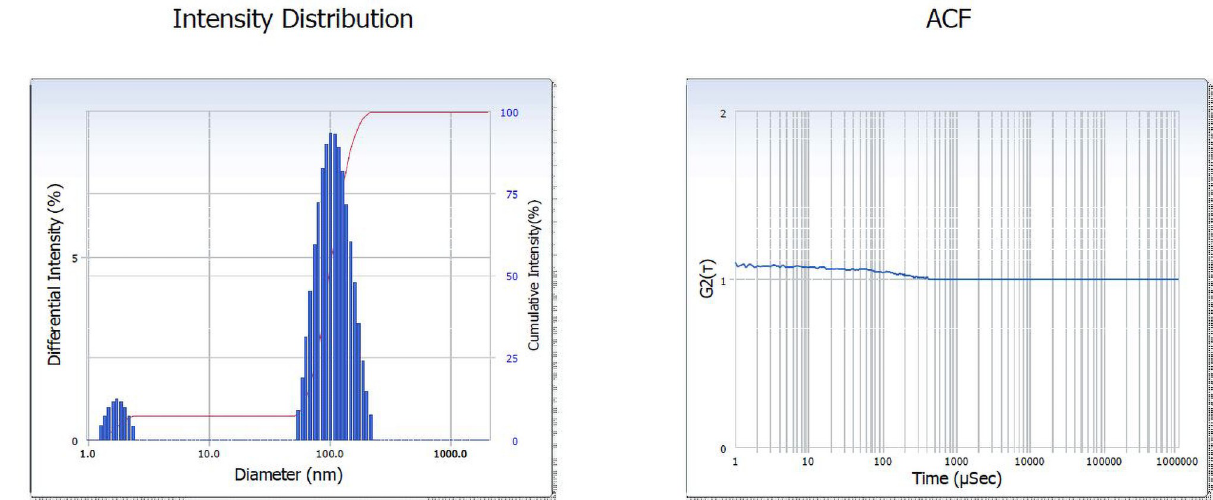
Fig 8. DLS results showing the diameter and polydispersity index of the silver nanoparticles.